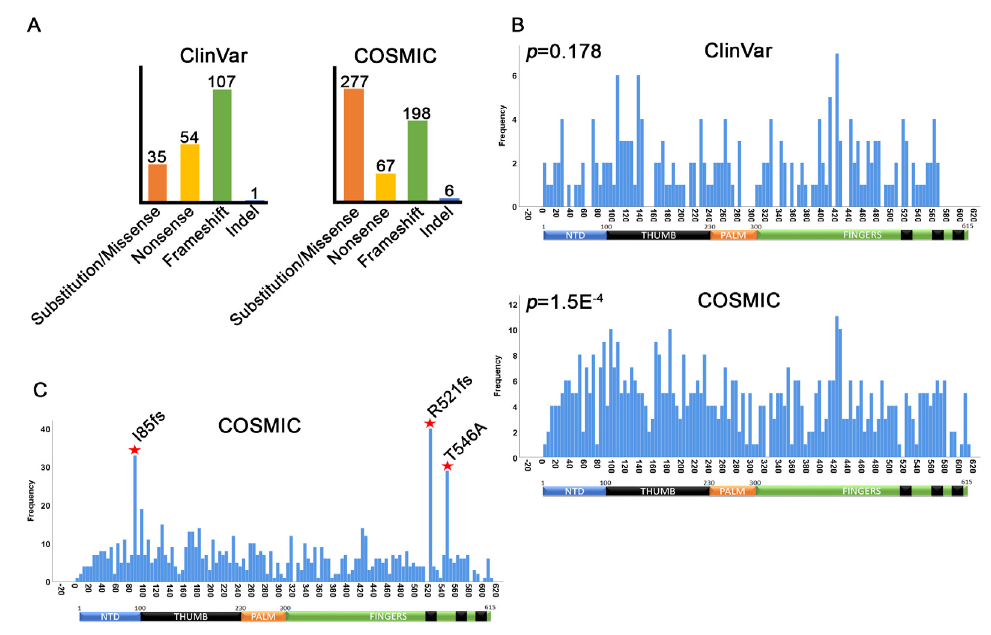
Figure 3. Open reading frame positions of ClinVar and COSMIC mutations. ( A ) Counts of unique residue mutation positions by mutation type. ( B ) Distribution histograms showing Kolmogorov–Smirnov P-values for uniformity. For COSMIC, only the 548 unique residues were mapped. ( C ) Histogram showing all COSMIC missense, nonsense, frameshift, and indel mutations (including duplicate) to identify hotspots. The mutations generating the three hotspots are shown.